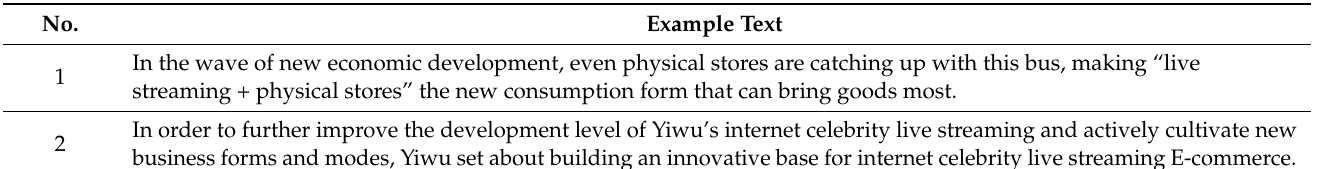
Table 4. Example text under the LDA sequence topic before policy